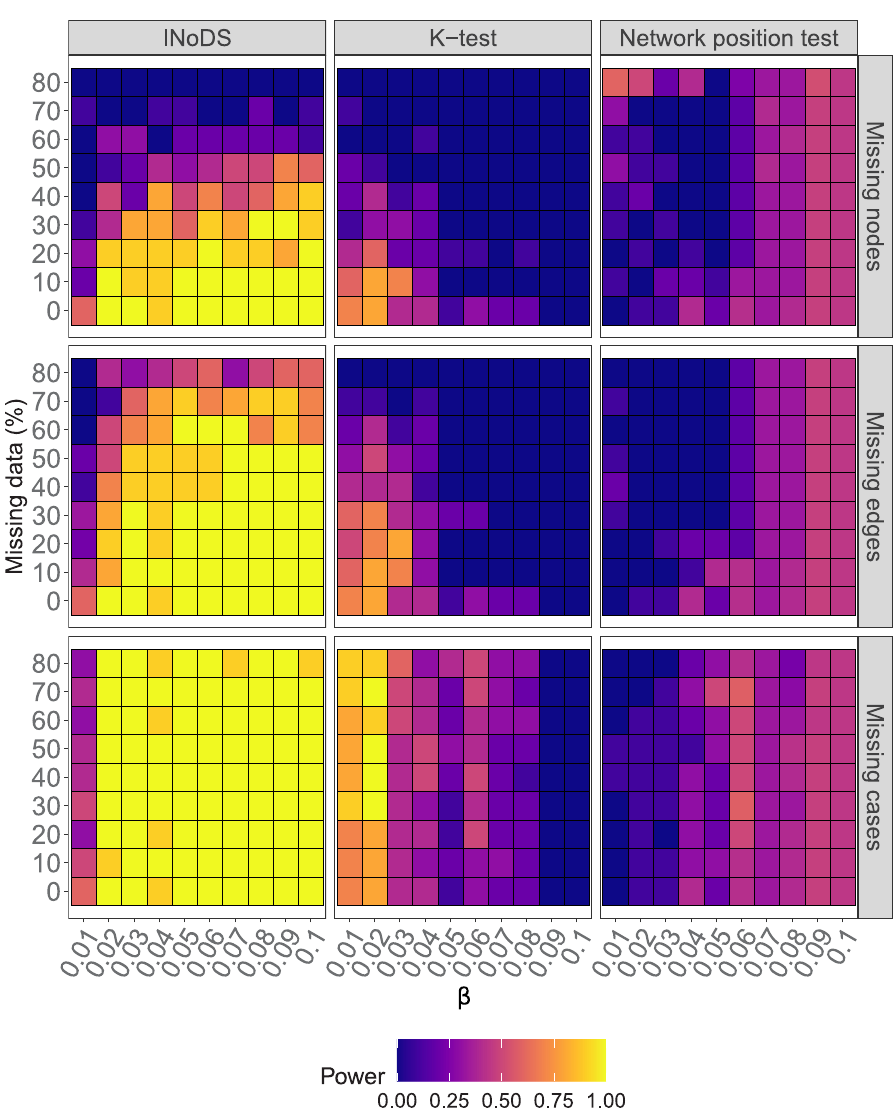
Fig 4. Comparison of INoDS performance with previous approaches. Statistical power of INoDS, k -test and network position test in establishing epidemiological relevance of the “true” contact network against three common forms of missing data—missing nodes, missing edges and missing infected cases. Statistical power of INoDS, k -test and network position test was calculated as the proportion of disease simulations where the observed contact network was detected as epidemiologically relevant (INoDS: log ( B 10 ) > 2.44; k -test and network position test: p <